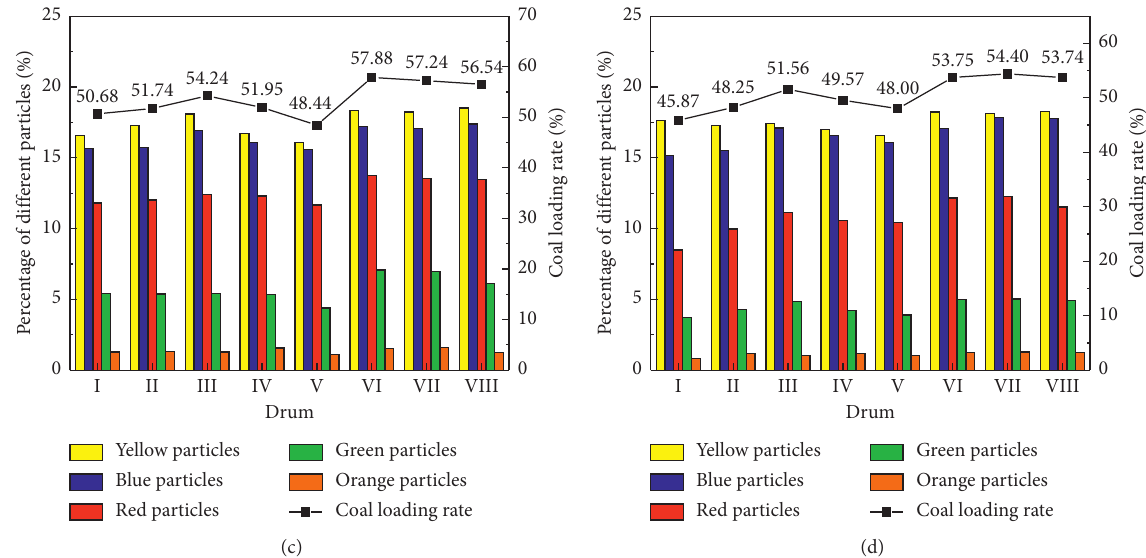
Figure 14: The relationship between the loading coal particles with different web depths at different rotational speeds and the coal loading rate of the drum: (a) 40rpm, (b) 60 rpm, (c) 80rpm, and (d) 100 rpm.